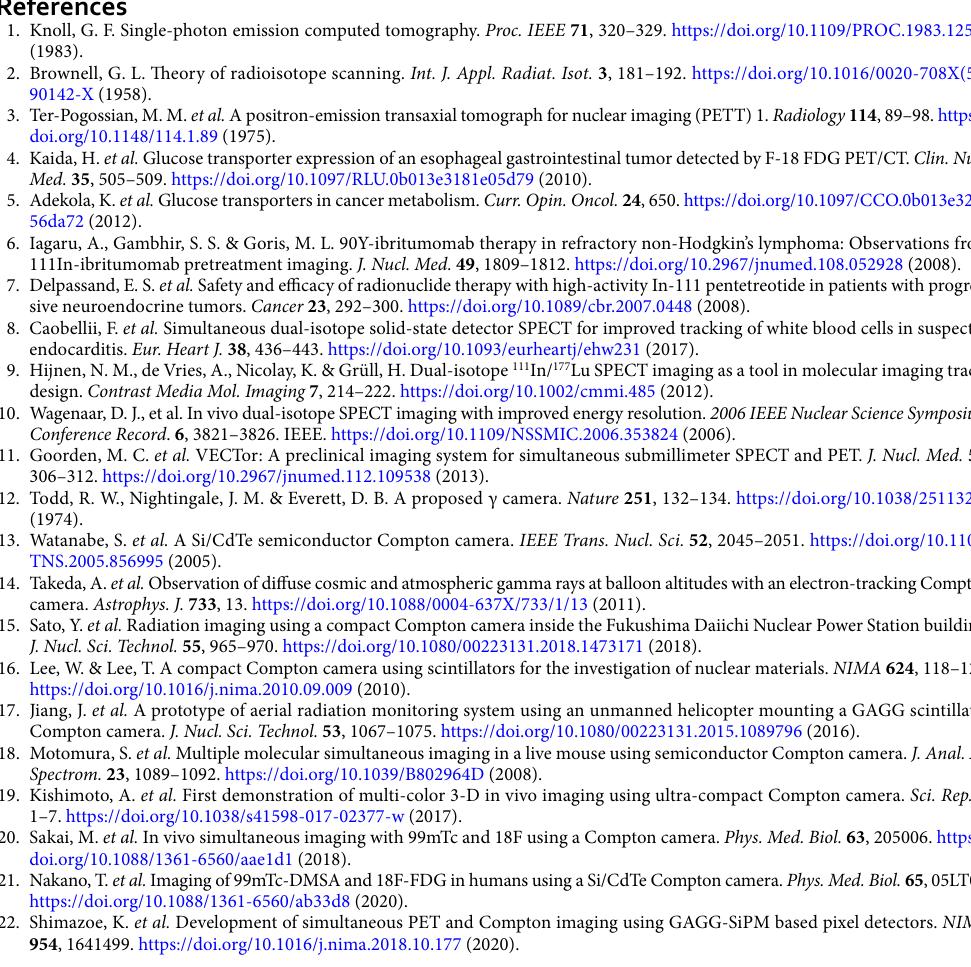
of 111 In in order to suppress artifacts in the images caused by crosstalk elements. The experimental setup of the two modules was the same as in Fig. 8, and the mouse was placed at the center between the two modules, and scanned under anesthesia (isoflurane inhalation of 1.0–1.5% in air).